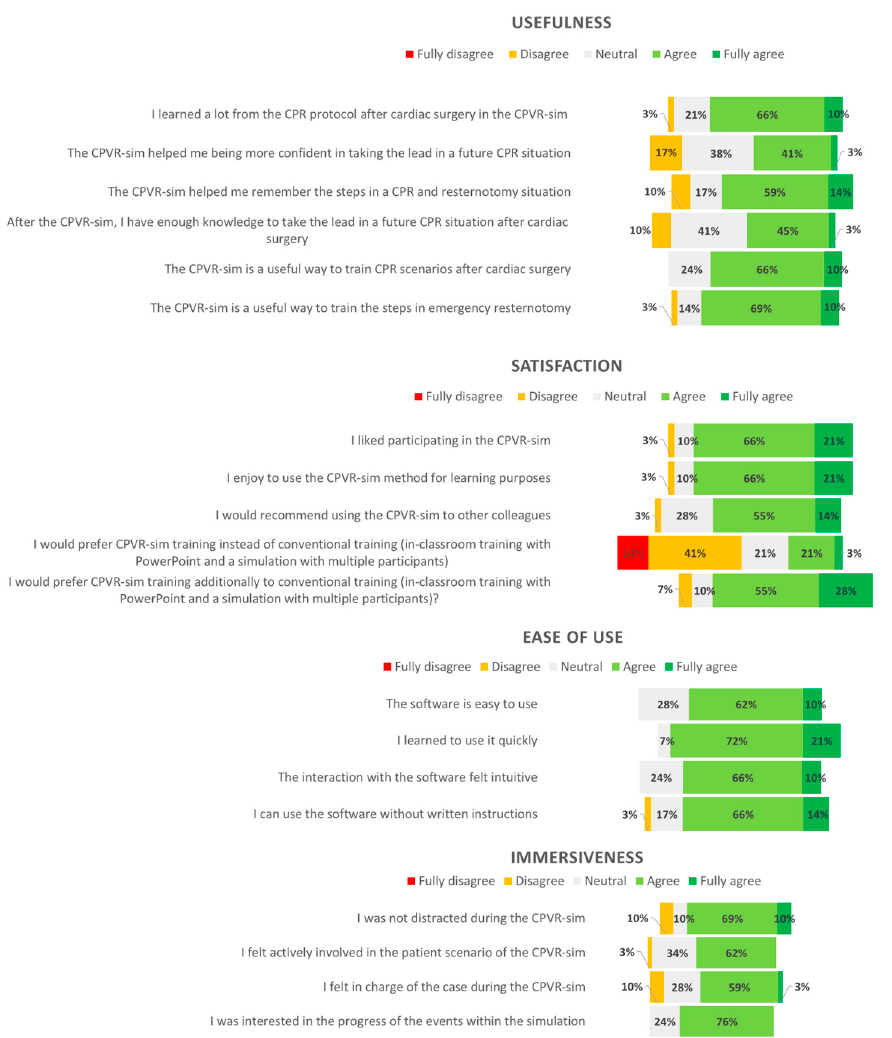
Figure 3. A diverging stacked bar chart demonstrating the usefulness, satisfaction, ease of use, and immersiveness data from participants rating the CPVR-sim. Inconsistencies in the sum of percentages is due to the rounding of the percentages. CPVR-sim—cardiopulmonary resuscitation virtual reality